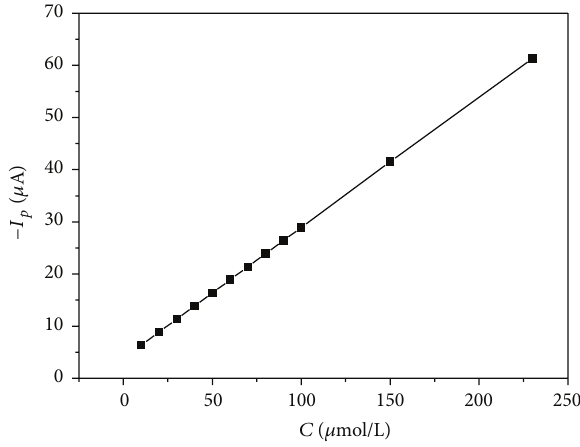
Figure 10: Standard curve of hydroquinone.